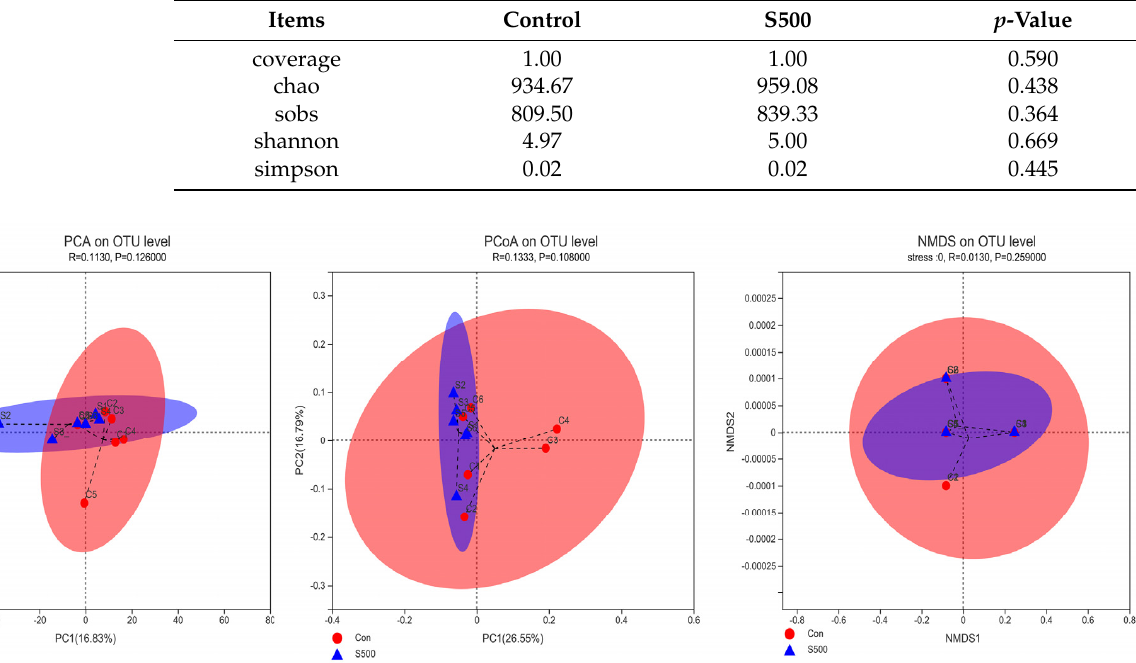
Figure 6. The microbial beta diversity was assessed by principal component analysis (PCA), principal coordinate analysis (PCoA), and nonmetric multidimensional scaling (NMDS) analysis based on the OTU table.